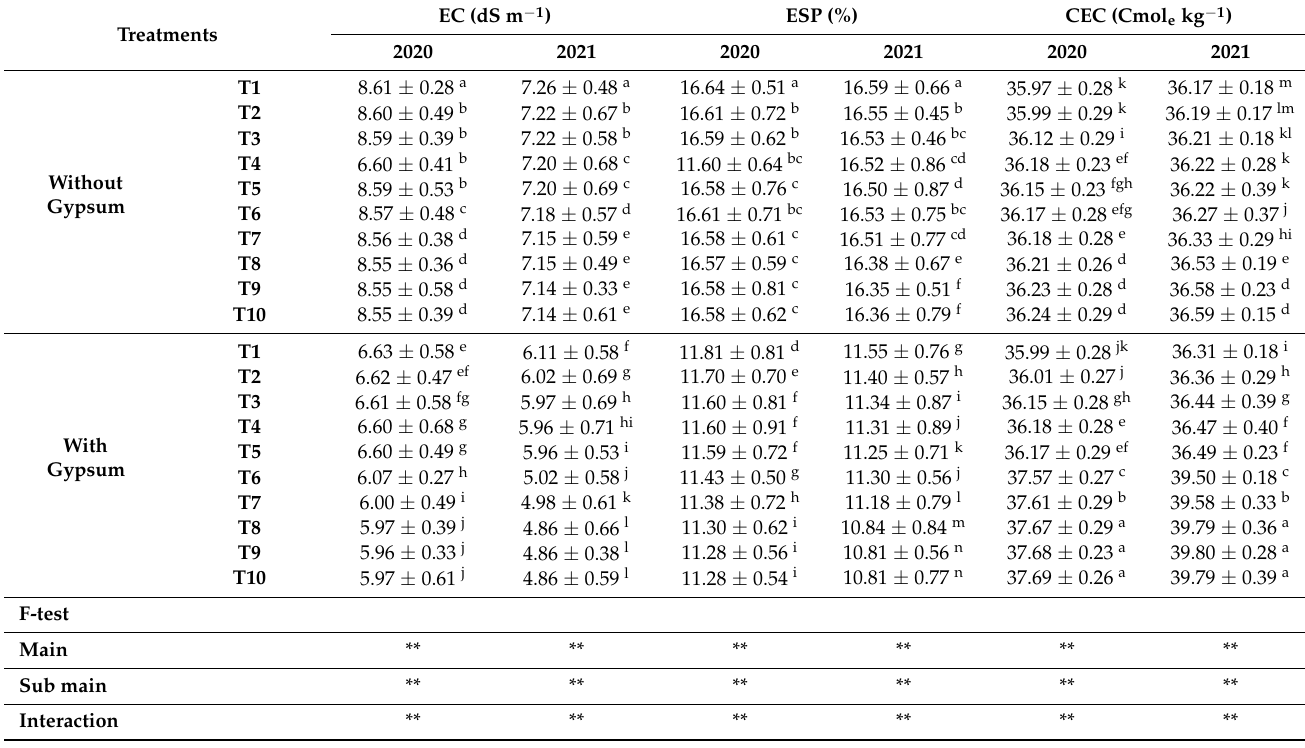
Table 6. Combined effects of gypsum and bio-priming with PGPR and different levels of chitosan (0, 25, 50, 75, and 100 mg L − 1 ), on soil chemical characteristics at 120 days from sowing during 2020 and 2021